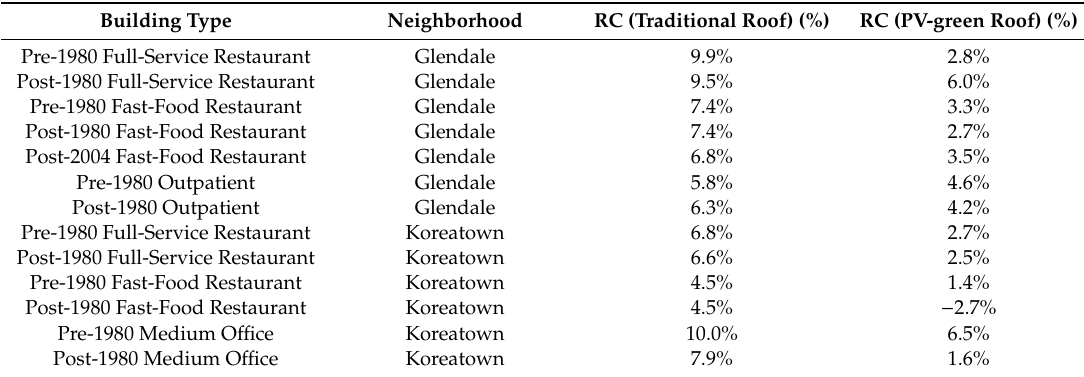
Table 5. Relative change (%) in annual electricity energy demand between 2050 and present (1991– 2005) in all tested buildings under the A1F1 emission scenario.